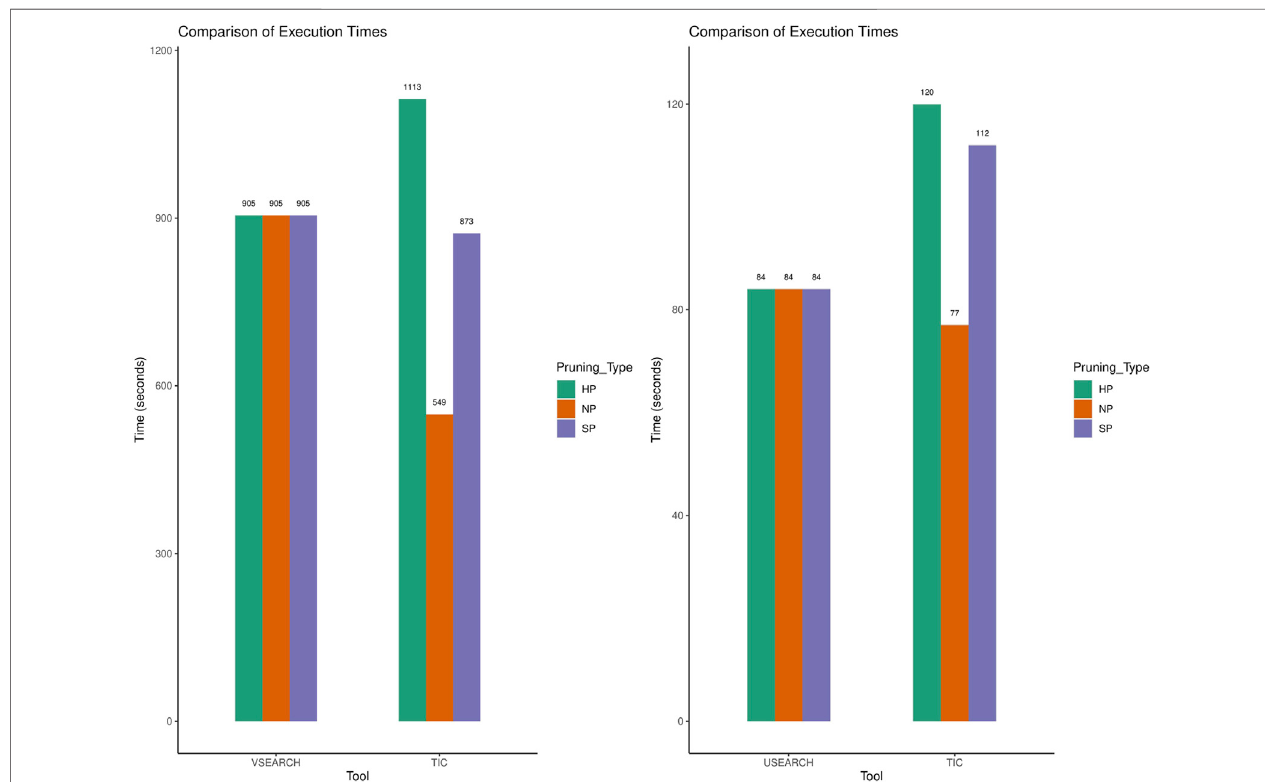
FIGURE 7 | Comparison of execution times for VSEARCH, USEARCH, and TIC running with each as an underlying tool respectively. Although slower, TIC is comparable with either tool regardless of the pruning method.